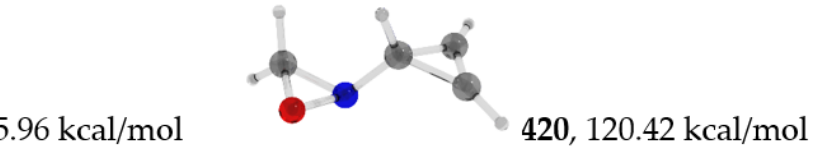
(kcal/mol). Hydrogen: light grey, Carbon: black, Nitrogen: blue, Oxygen: